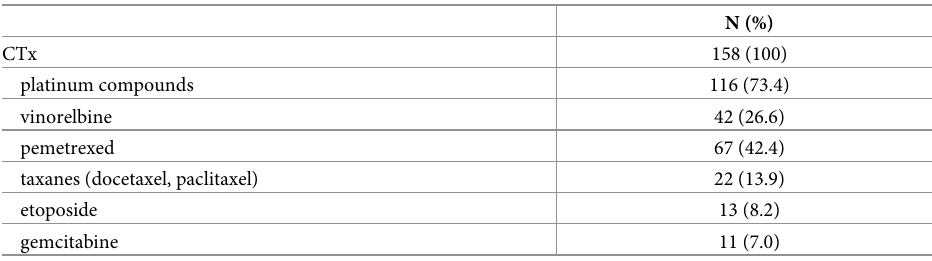
Table 2. Composition of CTx regimen.